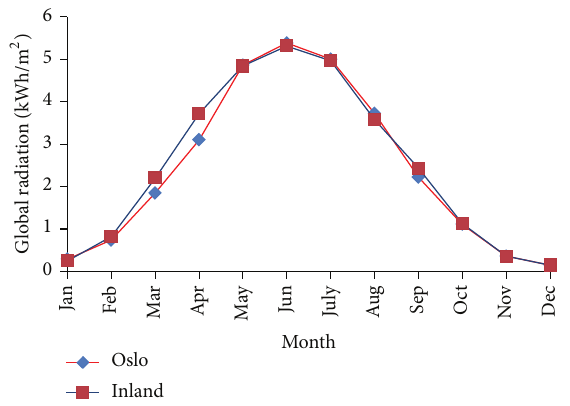
Figure 3: Satellite-derived monthly average daily global solar radiation for Oslo and Inland.